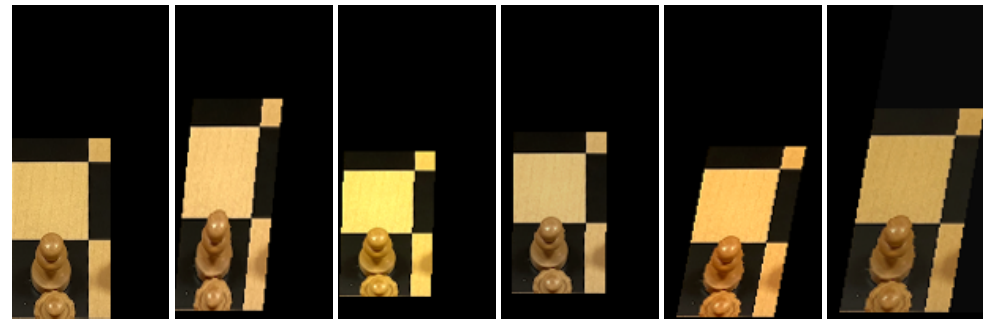
Figure 10. The augmentation pipeline applied to an input image (left). Each output looks different due to the random parameter